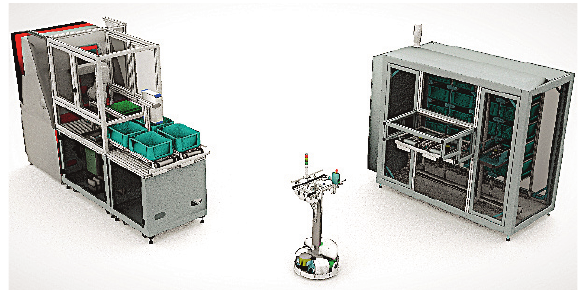
Fig. 4. Use case II – flexible manufacturing system.